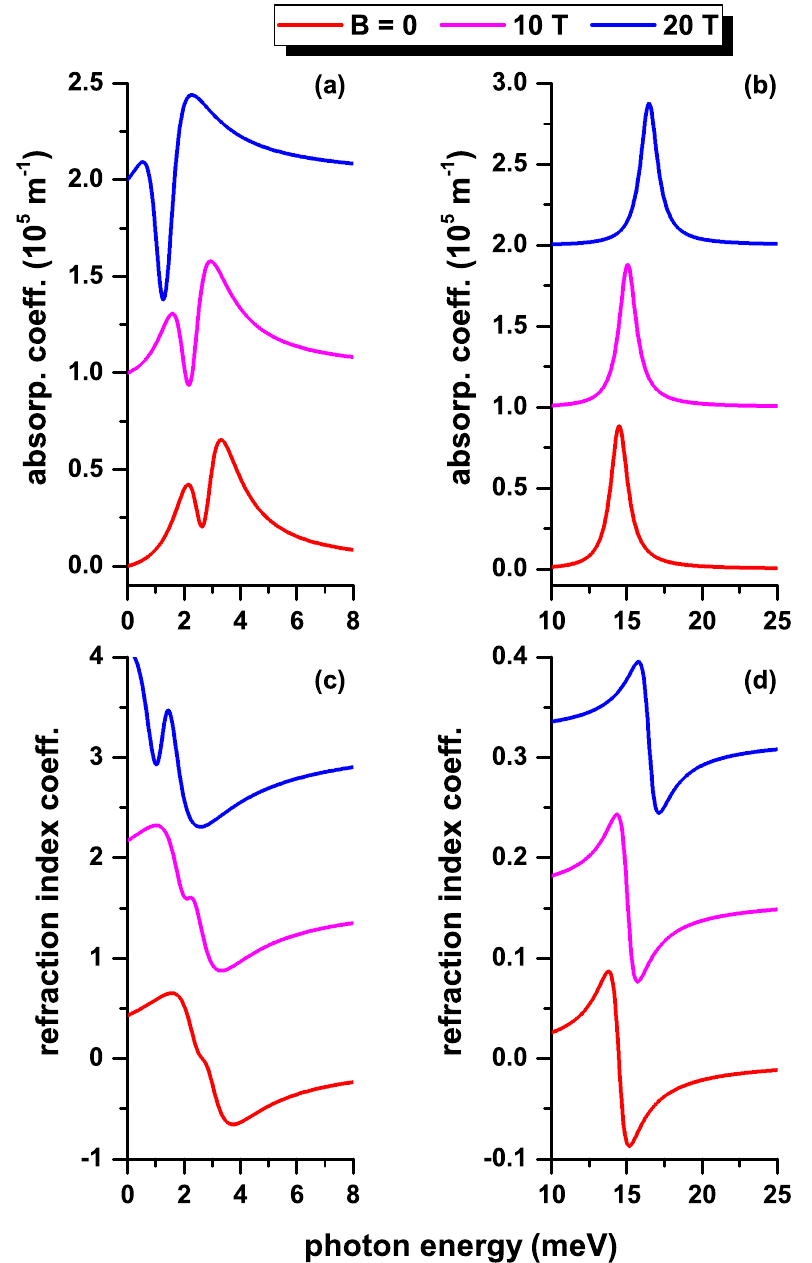
Figure 12. (color online) The total optical absorption coefficient ( a , b ) and the total relative changes of the refraction index coefficient ( c , d ) as functions of the incident photon energy in a CdS/ZnS spherical QD, for several values of the MF. Results are without ( a , c ) and with ( b , d ) on-center donor impurity, with R 1 = 20nm and R 2 = 30nm. Optical transitions are between the lowest confined l = 0 states, considering a central EF F = −